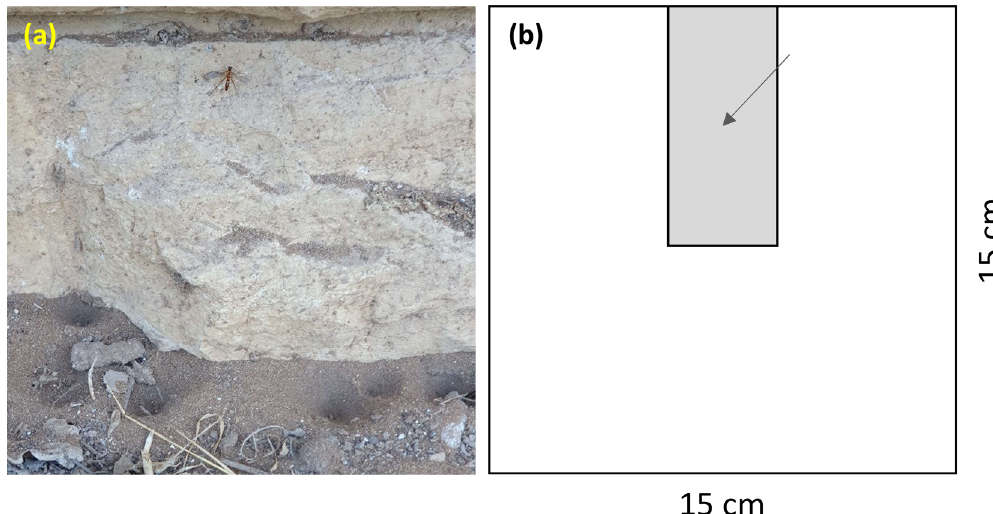
Figure 1. ( a ) Several pits constructed by wormlions beneath buildings at Tel Aviv University, Tel Aviv, Israel. An adult wormlion female is present on the wall, perhaps before or after oviposition (photo taken by the first author). ( b ) A scheme of the tray used for Experiments 1–4. Wormlions were always placed in the center of the rectangular area (marked with an arrow). The rectangular area (gray) in most cases contained better conditions than its surroundings (white), either shaded vs. lit sand or deep vs. shallow